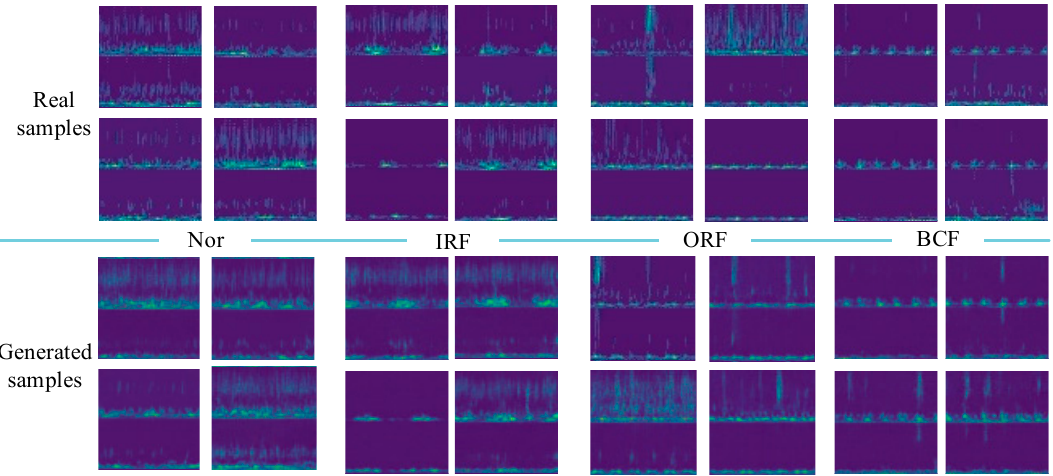
Figure 10. Comparison between the real samples and the generated samples.